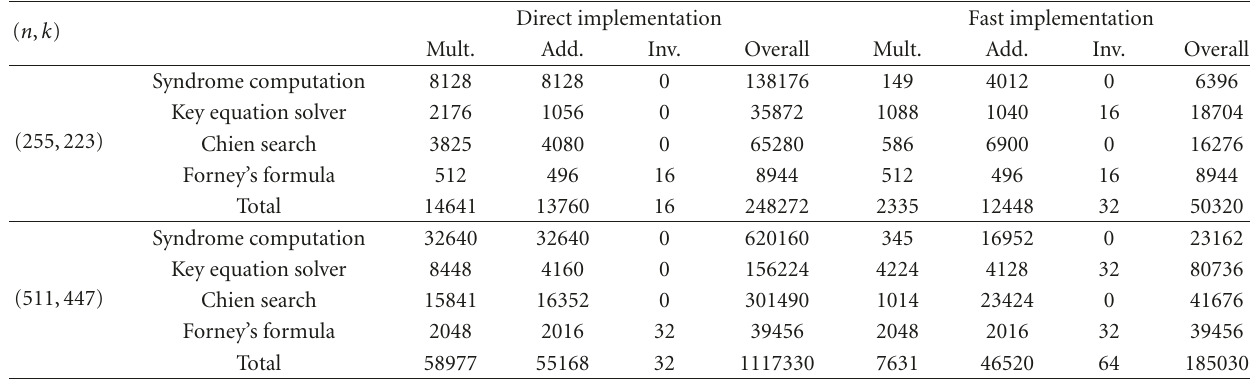
Table 6: Complexity of syndrome-based